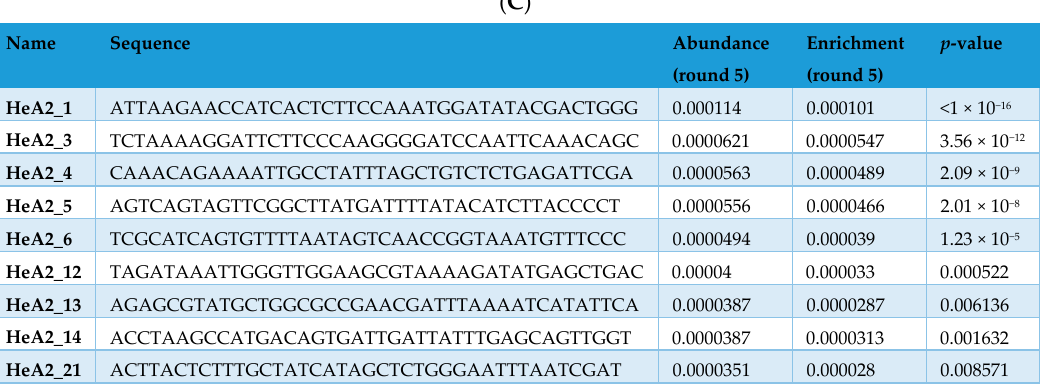
Figure 1. Aptamer selection. ( A ) Schematic overview of the adherent whole-cell SELEX approach; Five selection rounds were performed to enrich DNA aptamer sequences that bind to adherent SKBR3 cells on coverslips ( B ) Progress of the selection analysed by high throughput NGS; ( C ) Abundance of the 1000 most abundant sequences in selection round 5 in selection rounds 3, 4 and 5; ( D ) List of most promising DNA aptamer sequences after five rounds of selection in terms abundance (at round 5), enrichment (from round 4 to 5) and p -value. The sequences of the 40-mer random region are listed.